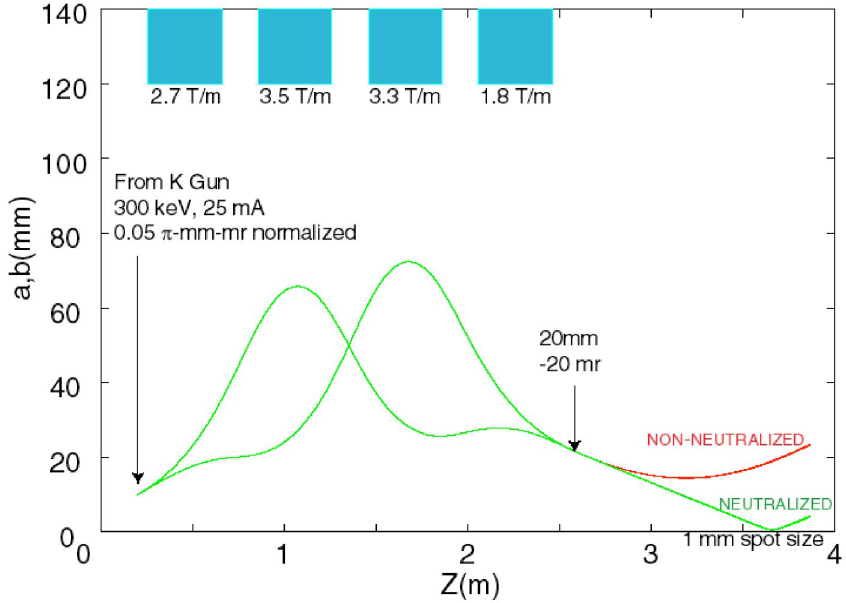
FIG. 14. (Color) Envelope simulation of transport in NTX magnetic